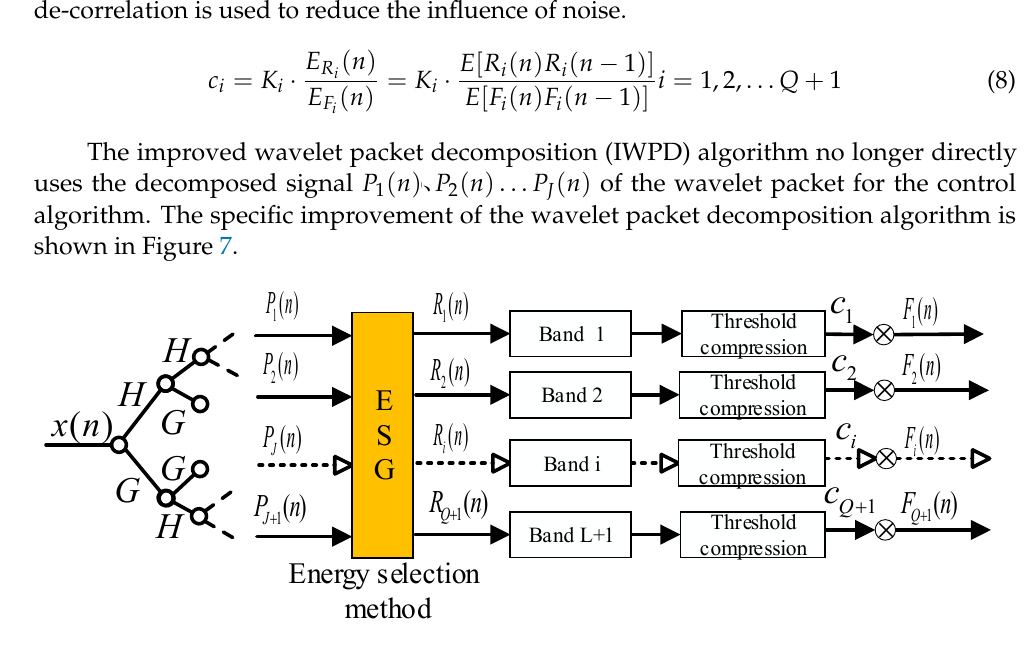
Figure 7. The structure schematic diagram of the IWPD algorithm.